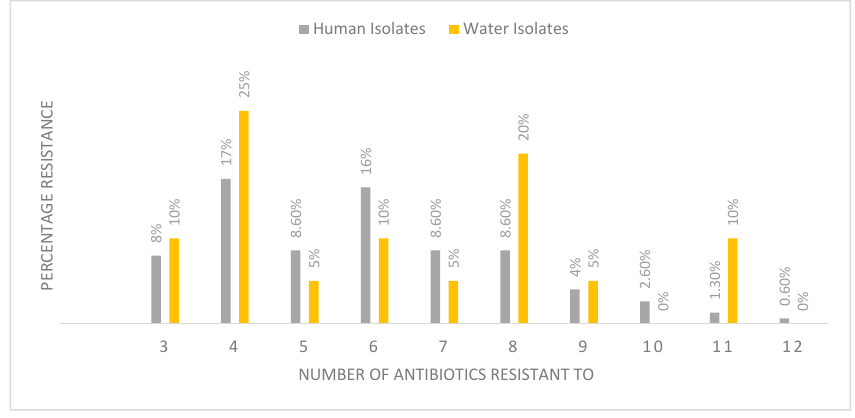
Figure 1. The overall percentage of multi-antibiotic resistance of Campylobacter isolates.